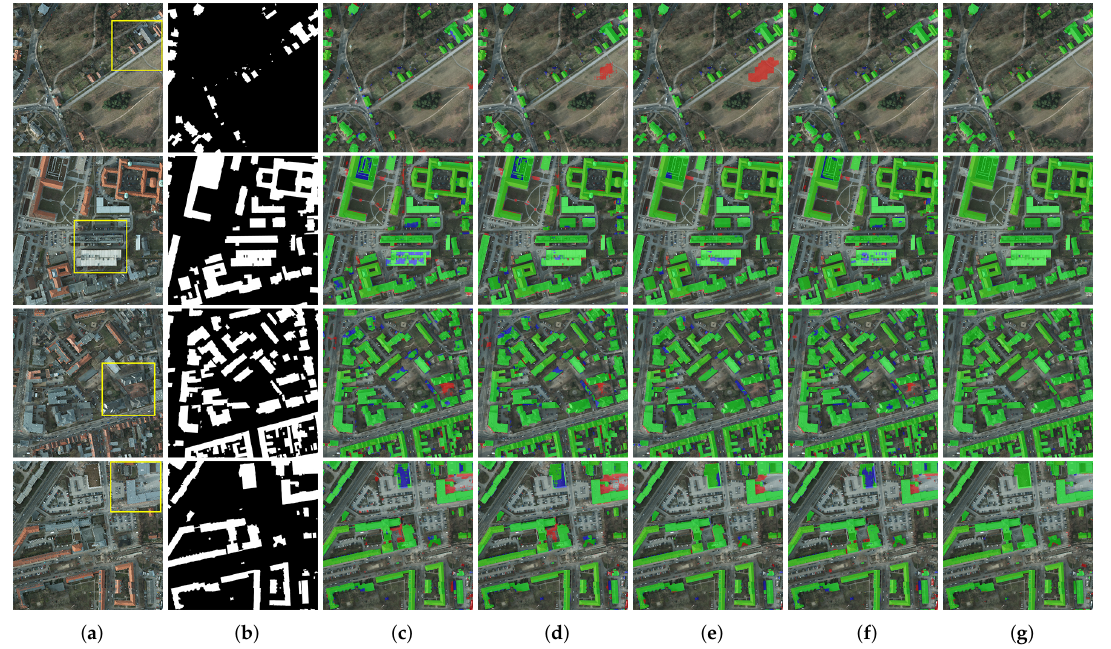
Figure 9. Examples of building extraction results obtained by different methods on the Potsdam dataset. ( a ) Original image. ( b ) Ground-truth. ( c ) U-Net. ( d ) DeepLab-v3+. ( e ) DANet. ( f ) MA-FCN. ( g ) BARNet. Note, in Columns ( c – g ), green, blue and red indicate true-positive, false-negative and false-positive, respectively. The yellow rectangles in ( a ) are the selected regions for close-up inspection in Figure